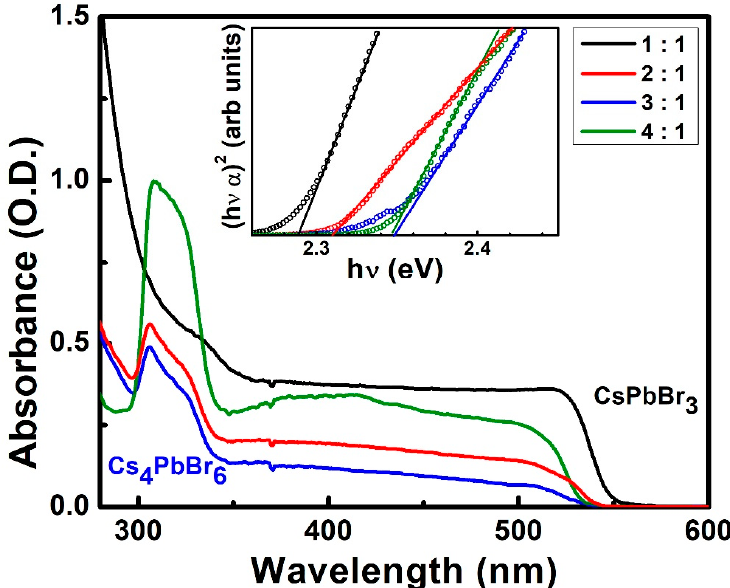
Figure 6. Absorption spectra of the films with di ff erent molar ratios of precursors indicated in the label. The inset reports the Tauc plots for the determination of the absorption